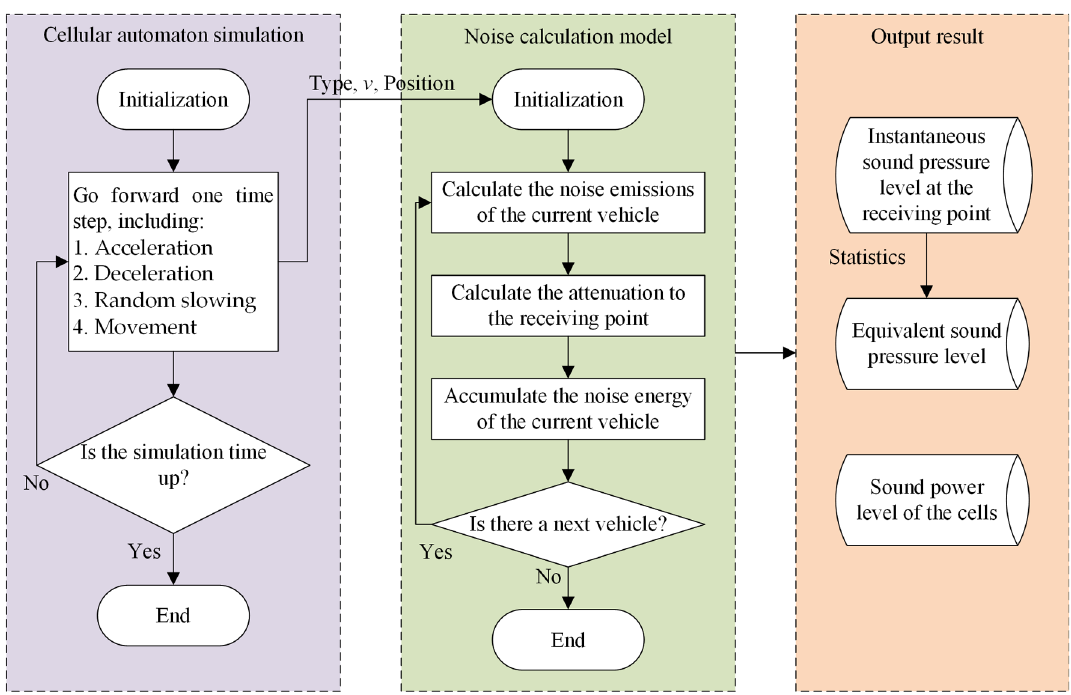
Figure 3. The logical framework diagram of traf fi c noise dynamic simulation includes three parts: cellular automaton traf fi c fl ow simulation, dynamic traf fi c noise calculation, and result